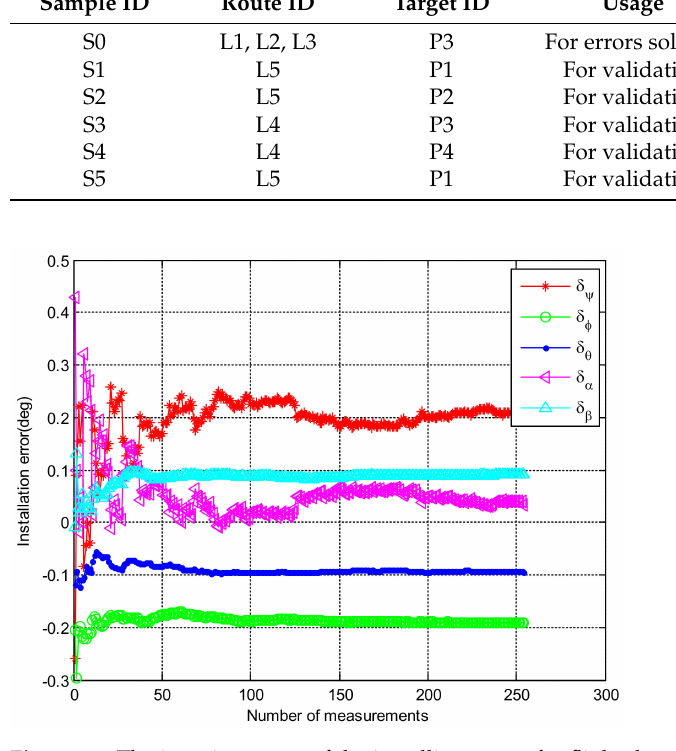
Figure 11. The iteration curve of the installing errors for flight